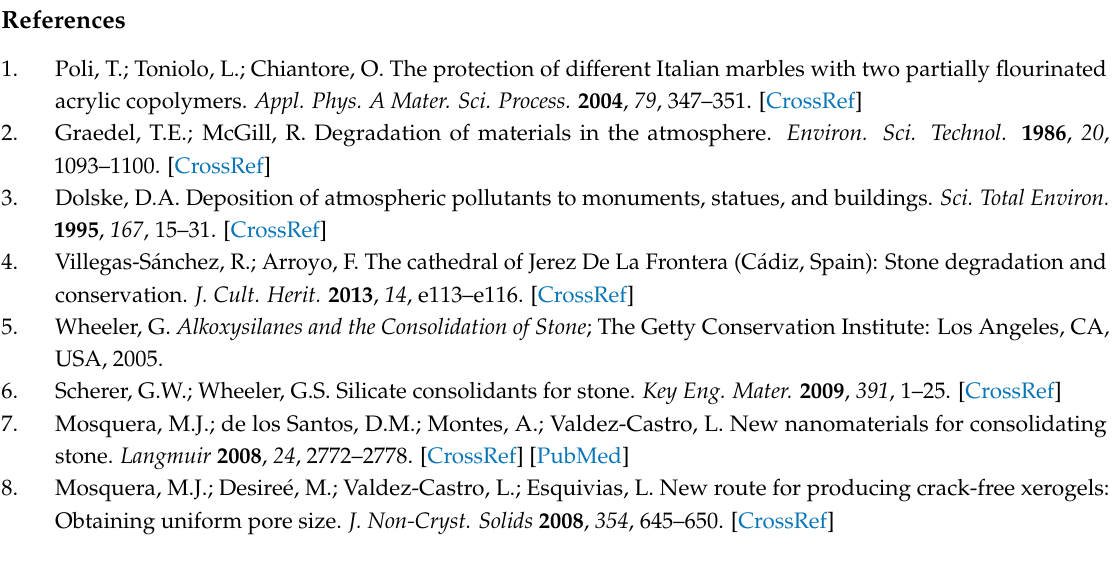
Table S1: Static, advancing and receding CA values and their corresponding hysteresis CA for the treated stones. Author Contributions: D.S.F. and J.A.O. performed the experimental work. M.L.A.G. and L.A.M.C. participated in writing and interpretation of results. M.J.M. planned the experimental work, analyzed the results and wrote the